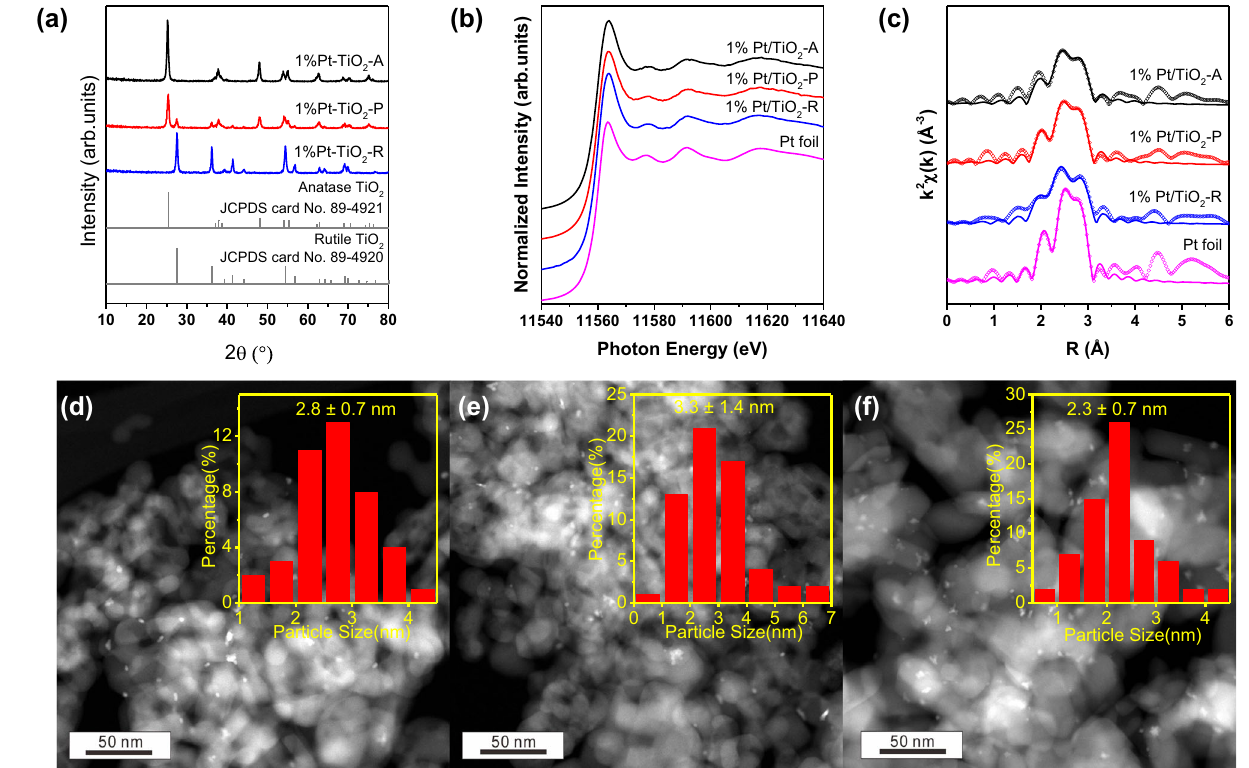
Fig. 2 | Structure characterization ofPt/TiO 2 photocatalysts. a X-ray diffraction patternof1%Pt/TiO 2 photocatalysts;( b )PtL 3 edgeXANESandEXAFSspectraof1% Pt/TiO 2 -A, -P and -R catalysts together with Pt foil reference; ( c ) the fi tting EXAFS